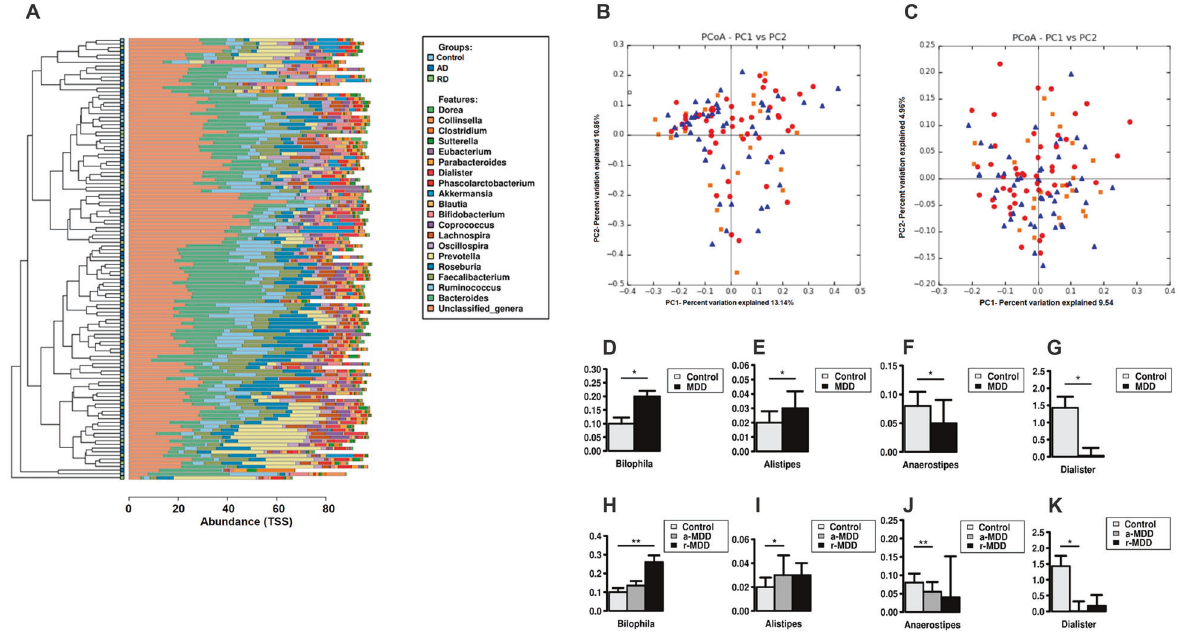
Fig. 1 Metataxonomic analysis and abundance of bacteria genera in fecal samples. A Comparison of the relative abundance of the 20 most abundant genera (TSS; total-sum normalization) in the three groups of subjects. The dendrogram was based on genera similarity between the samples. Hclust with complete linkage method from the Calypso online software was used to compute the hierarchical clustering. PCoA plots of bacterial pro fi les based on Bray – Curtis similarity analysis (relative abundance) ( B ) and on the Jaccard ’ s coef fi cient for binary data (presence/ absence) ( C ) from the three groups of subjects (blue triangle, control group; red circles, a-MDD group; orange squares, r-MDD group). The value given on each axis label represents the percentage of the total variance explained by that axis. Relative abundance of the genera Bilophila ( D ), Alistipes ( E ), Anaerostipes ( F ), and Dialister ( G ) in MDD patients compared with HC. Patients with r-MDD presented an increased presence of sequences belonging to the genus Bilophila ( H ). Patients with a-MDD showed increased abundance of sequences belonging to the genus Alistipes ( I ), while those corresponding to the genera Anaerostipes and Dialister were decreased ( J , K ). Differences in sample group genera were compared by using either the Wilcoxon rank test for variables with two groups or the Kruskal – Wallis test for variables with more than two groups. To correct for multiple comparisons, Bonferroni-adjusted signi fi cance levels were set for each analysis. * p < 0.05, ** p < 0.01 vs. healthy controls